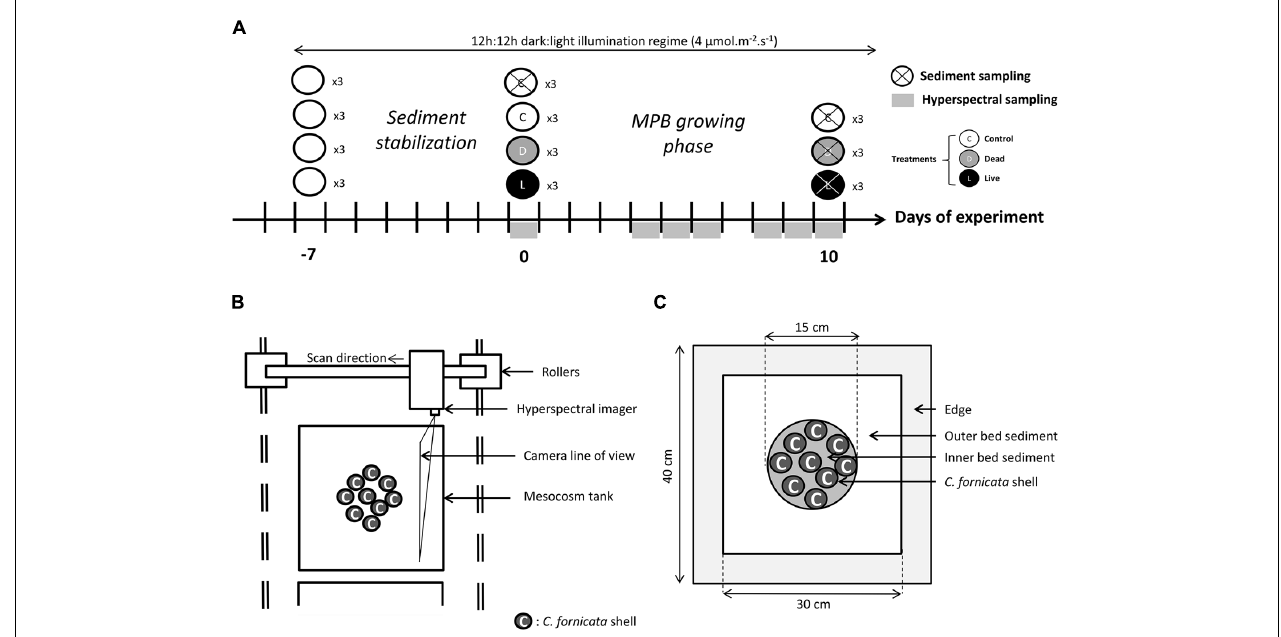
FIGURE 1 | Timeline of the experimental protocol and sampling design (A) , top-view schematic of the hyper-spectral imaging system (B) , and regions of interest within each mesocosm tank (C) .